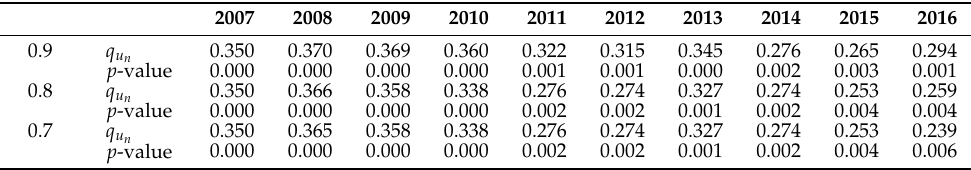
Table 12. The TQCC estimation between carbon inequality (based on a 4-year rolling window) and regional carbon efficiency from 2007 to 2016 with uq = 0.9, 0.8 and